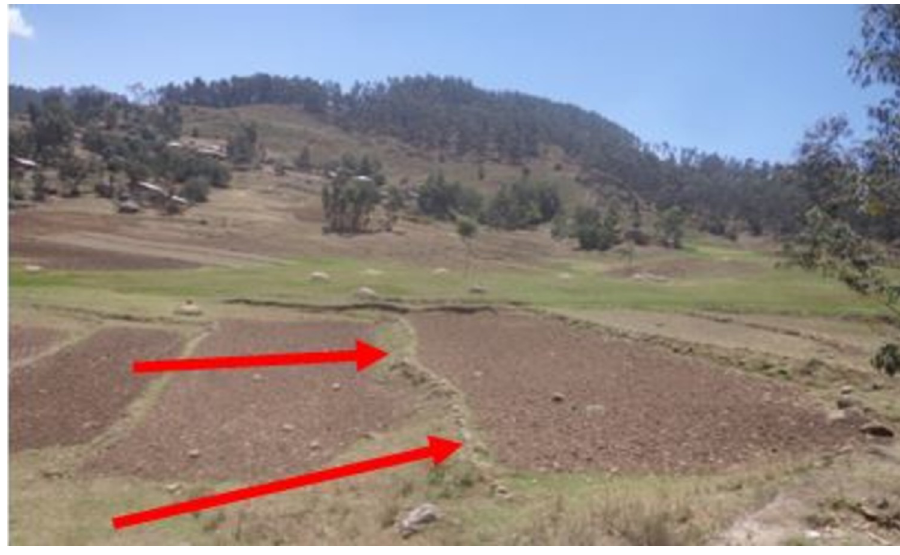
Fig 4. Stone-faced soil